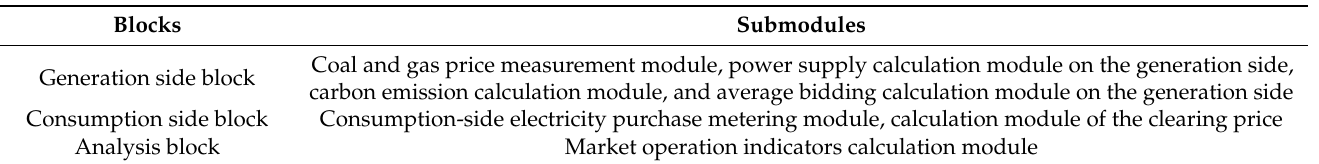
Table 1. Power market operation situation system dynamics model module